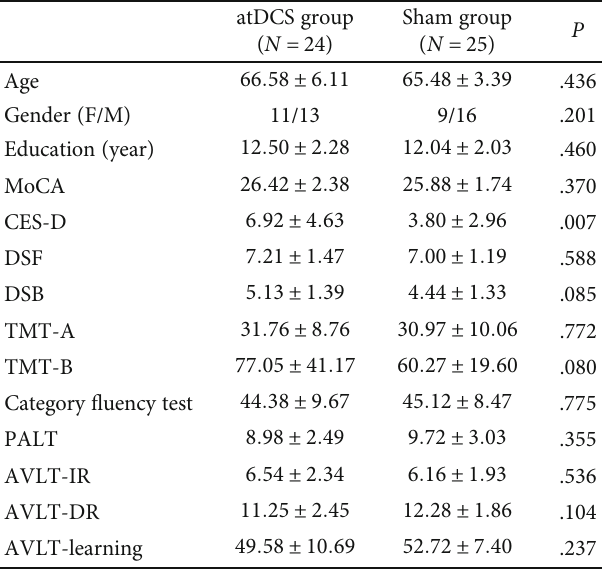
Table 1: Demographic characteristics and neuropsychological results at baseline for the stimulation and control